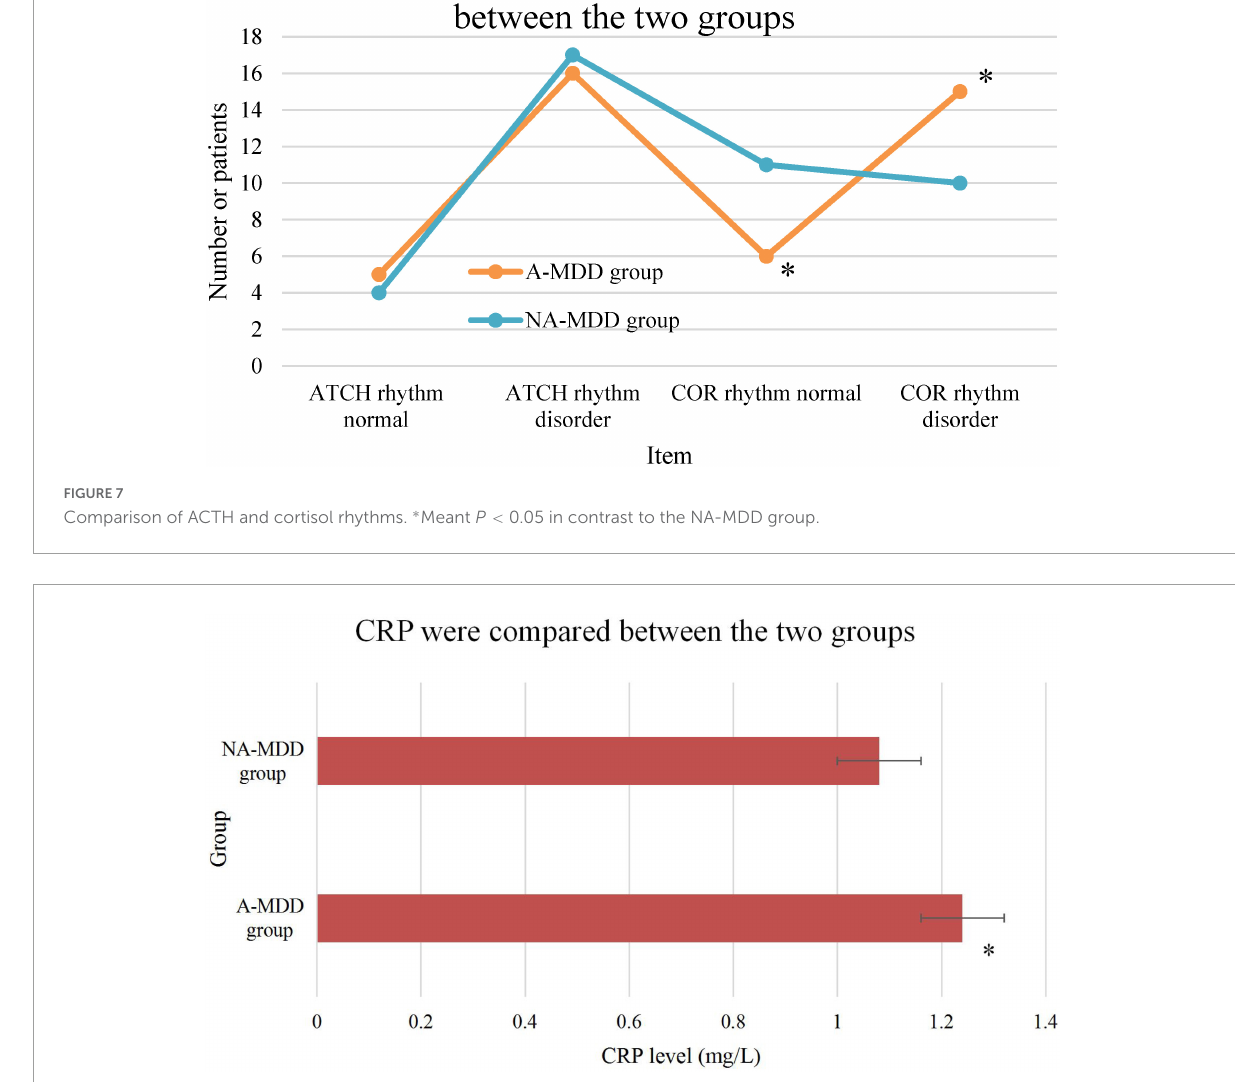
FIGURE8 Comparison of CRP between the two groups. ∗ Meant that compared with the NA-MDD group, the difference was statistically significant ( P <